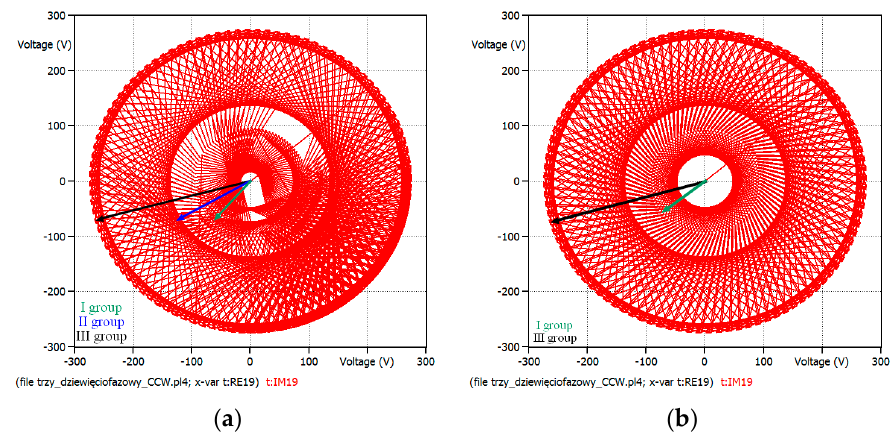
Figure 11. Trajectory of the output voltage rotating space vector for output frequency: ( a ) 30 Hz and ( b ) 50 Hz. Simulations performed for the voltage transfer ratio k U = 0.5, for one period of output frequency and CCW method.